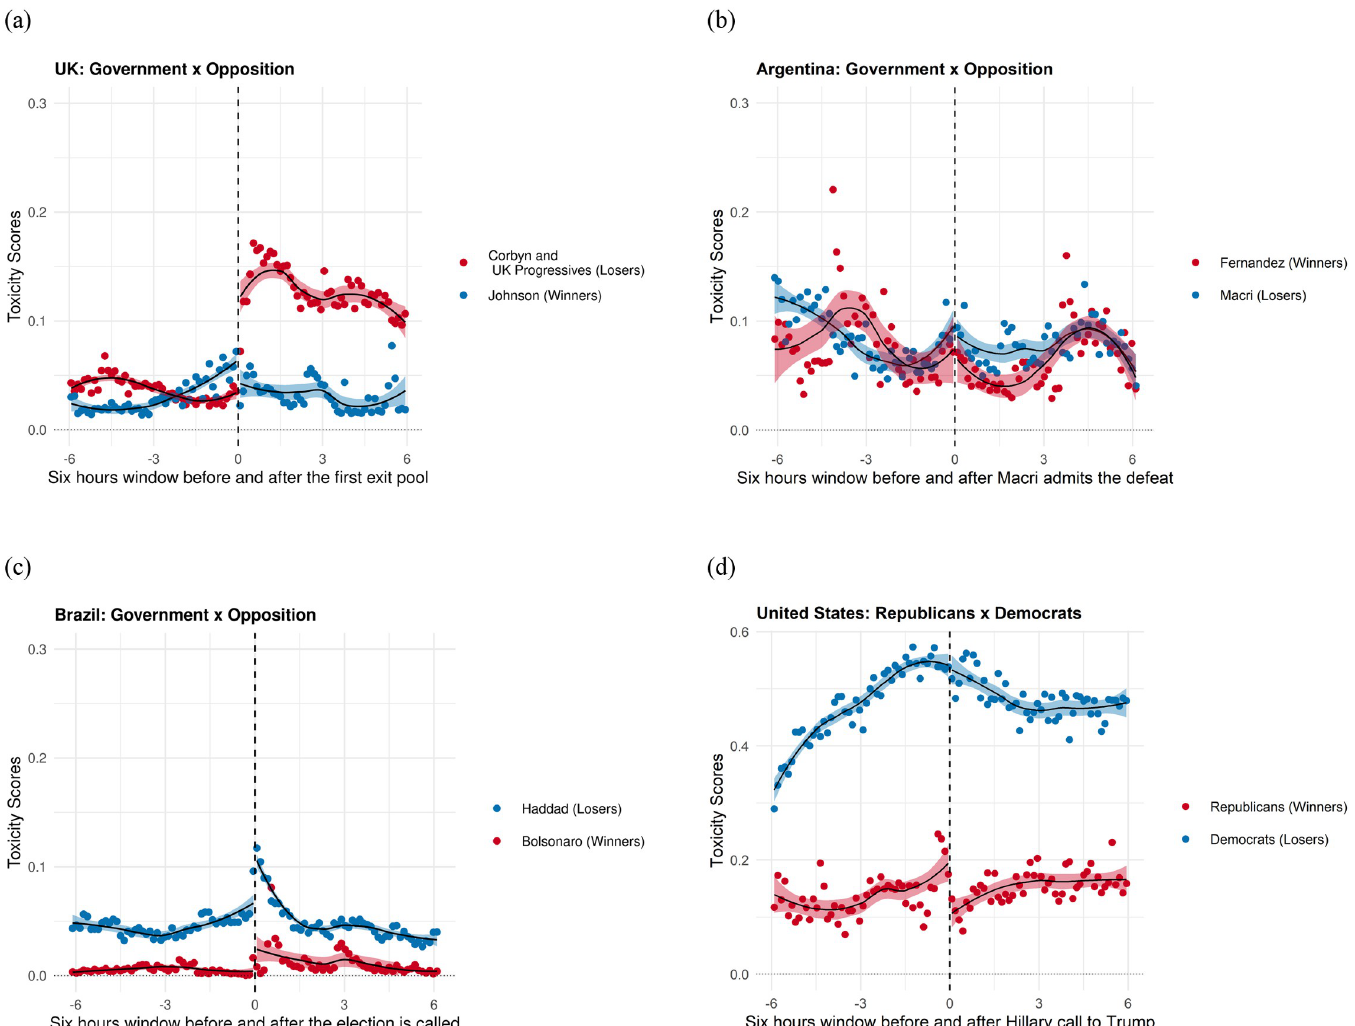
Fig 7. Toxicity scores of all the four election nights. (a) UK Election, (b) Argentina Election, (c) Brazil Election, (d) US Election.